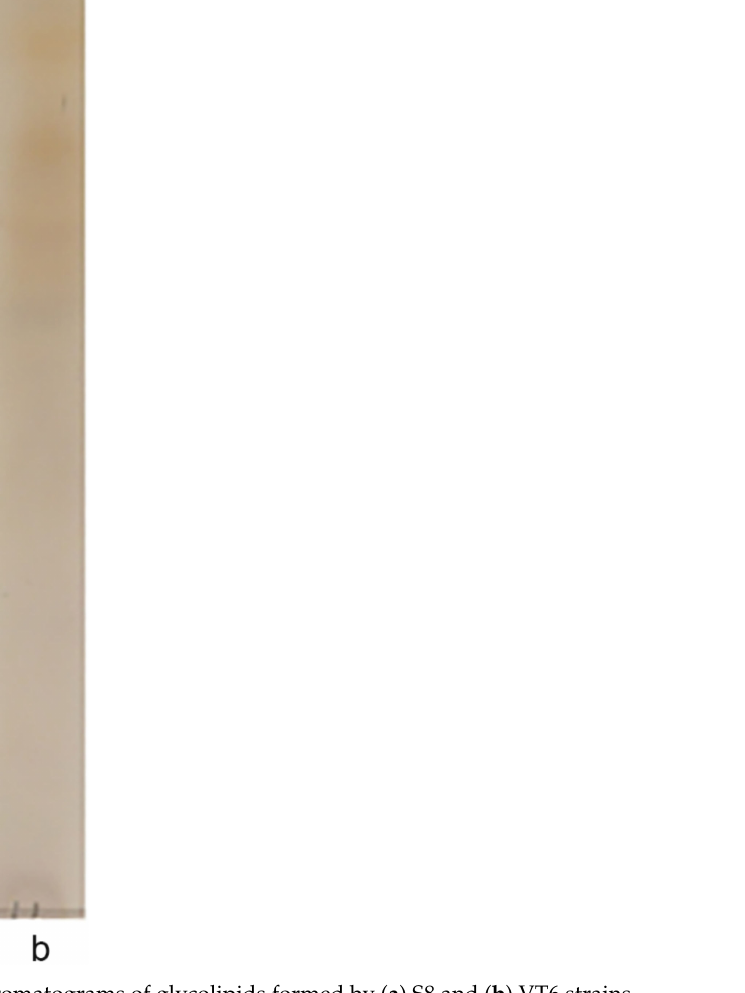
Figure 4. Chromatograms of glycolipids formed by ( a ) S8 and ( b ) VT6